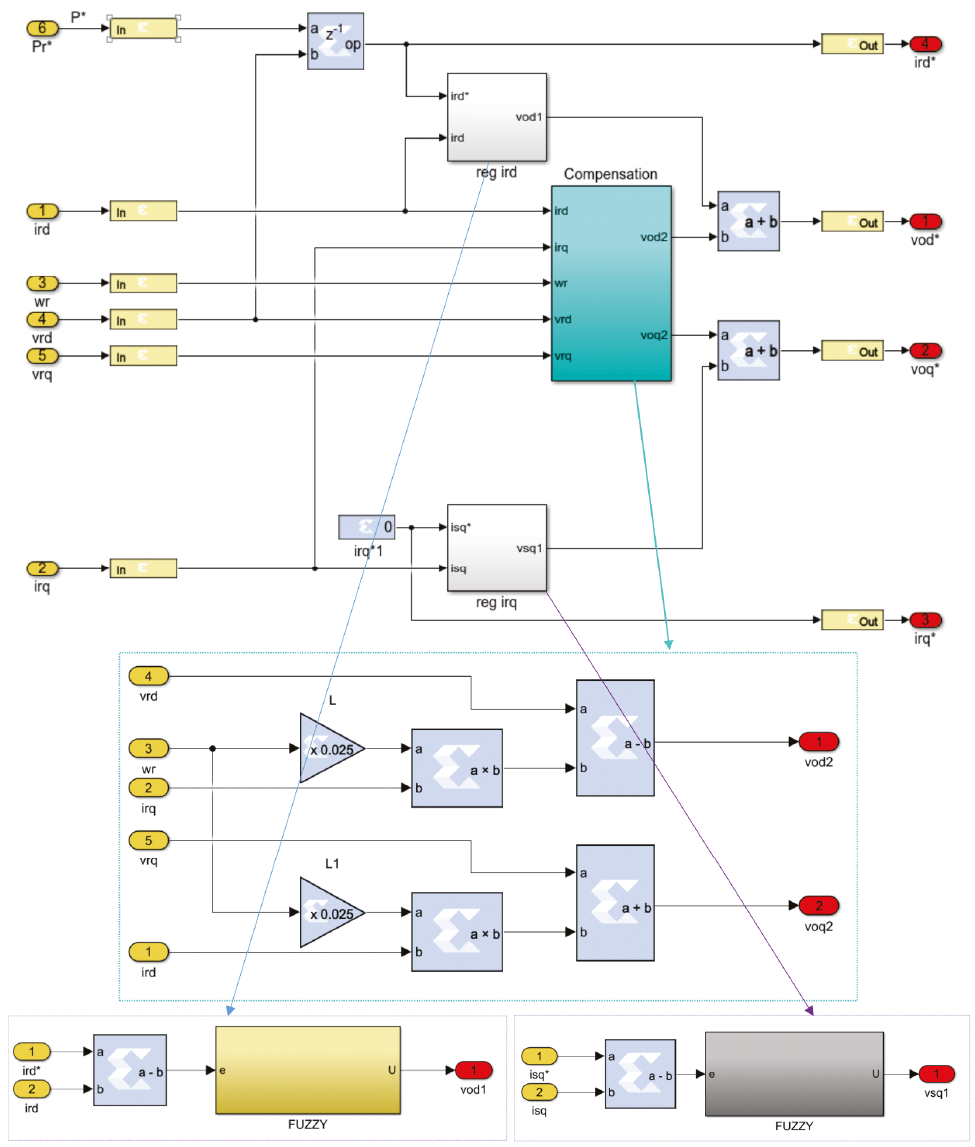
Figure (cid:561) 17. (cid:561) Hardware (cid:561) design (cid:561) of (cid:561) VCS-FGS-PID (cid:561) controllers (cid:561) for (cid:561) grid-side (cid:561) converter. (cid:561) Where (cid:561) (*) (cid:561) is (cid:561) Figure 17. Hardware design of VCS-FGS-PID controllers for grid-side converter. Where (*) is added added (cid:561) to (cid:561) distinguish (cid:561) between (cid:561) the (cid:561) actual (cid:561) and (cid:561) the (cid:561) references (cid:561) variables. (cid:561) to distinguish between the actual and the references 4.1.3. (cid:561) Design (cid:561) of (cid:561) Membership (cid:561) Functions (cid:561) Using (cid:561) XSG (cid:561) (cid:561)